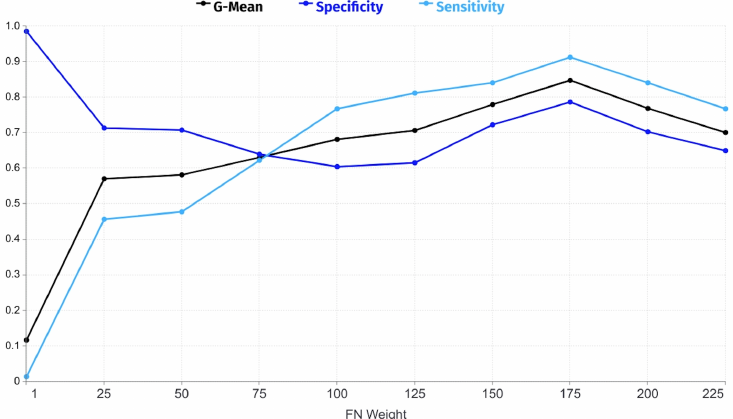
Figure 11. The effects of FN prediction weight on g-mean, specificity, and sensitivity when using the cost-sensitive MHOANN with the CSO for the dataset of Polish